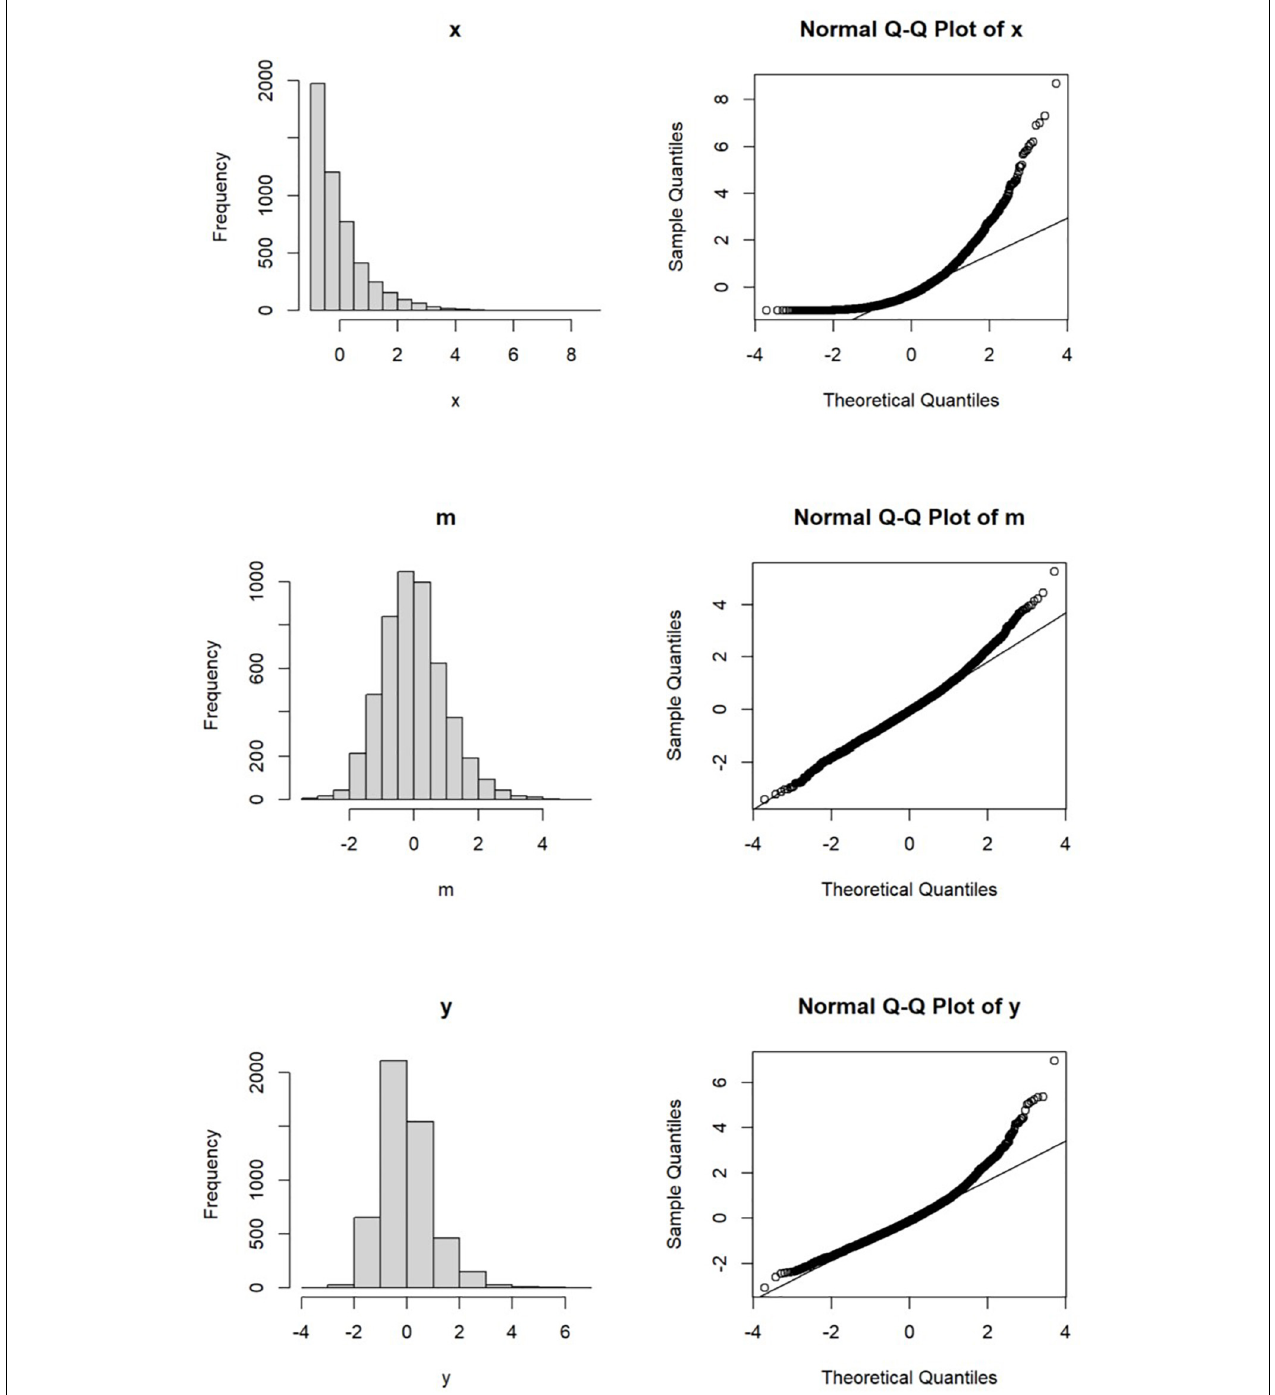
FIGURE 2 | Distributions of x , m and